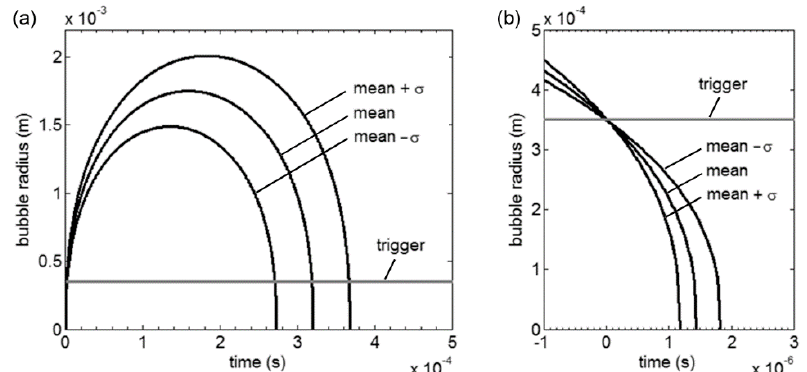
Figure 3. ( a ) Graph of the estimated bubble radius as a function of time for the average, the average plus standard deviation, and the average minus standard deviation bubble. The interval of time when the collapse can occur is 94 µs. ( b ) Zoom in and superposition of the collapse curves, as if the trigger was set at 20% of the average maximum radius. The interval of time when the collapse can occur is drastically reduced from 94 µs to 0.65 µs.